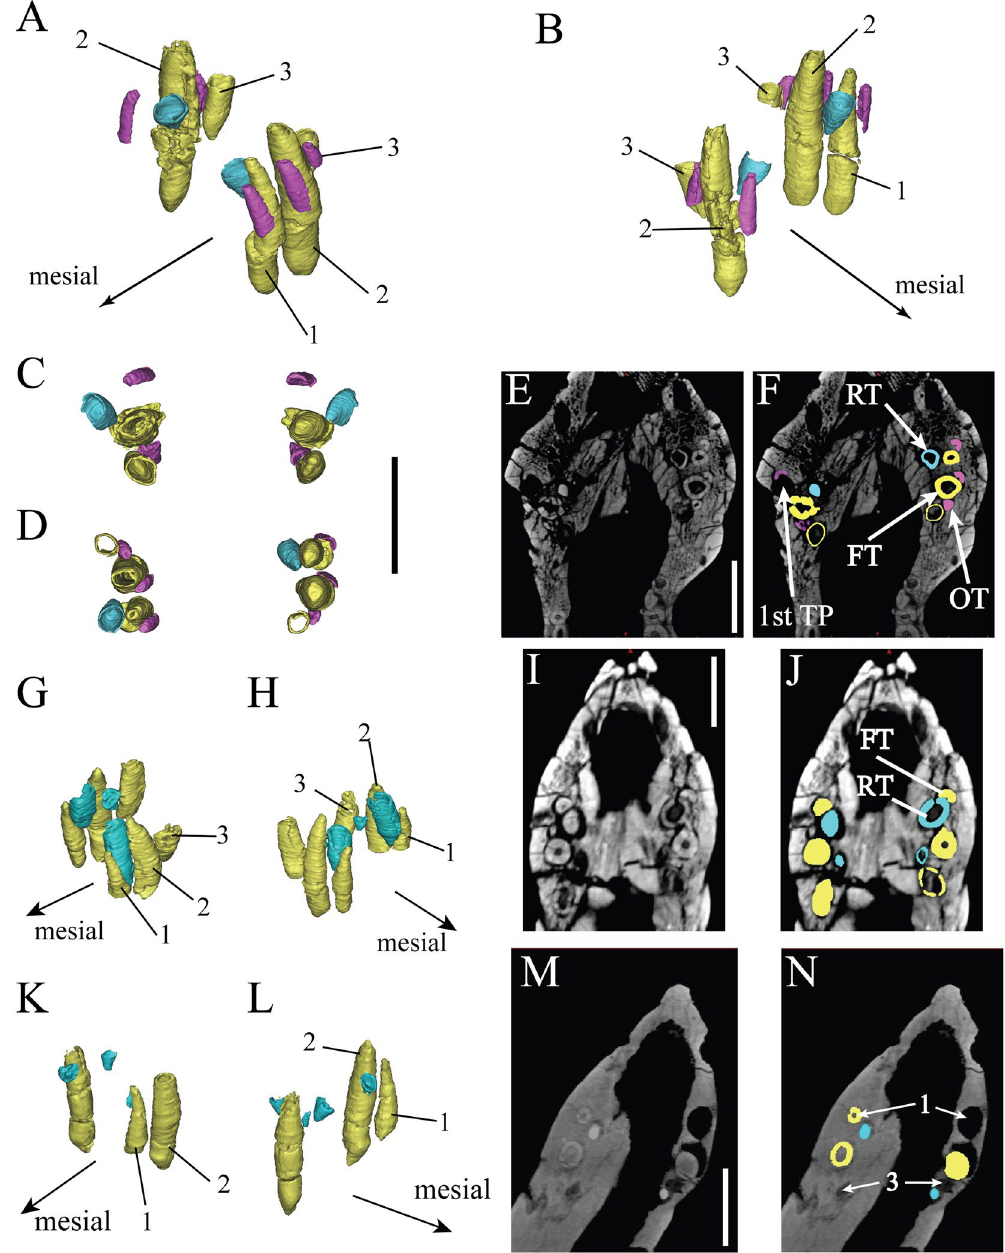
Figure 1. Liaoceratops yanzigouensis premaxillary teeth of IVPP V12738 ( A – F ), IVPP V12633 ( G – J ) and CAGS-IG-VD-002 ( M – R ). Elements in the CT reconstructions are color-coded as follows: right and left functional premaxillary teeth, yellow; right and left replacement premaxillary teeth, cyan; right and left remnants of mostly resorbed functional premaxillary teeth, magenta. Reconstructed and extracted premaxillary teeth composite in left ( A ) and right ( B ) mesial-labial view; ( C ) reconstructed and extracted left premaxillary teeth composite in dorsal (left) and ventral (right) view; ( D ) reconstructed and extracted right premaxillary teeth composite in dorsal (left) and ventral (right) view. ( E and F ) longitudinal CT cross sections through the premaxilla of IVPP V12738. Numbers indicate tooth positions from mesial to distal. Scale bars equal 10 mm ( C – F ). Reconstructed and extracted premaxillary teeth composite of IVPP V12633 in left ( G ), right ( H ) mesial- labial view; ( I , J) longitudinal CT cross sections through the premaxilla of IVPP V12633. ( K – N ) reconstructed and extracted premaxillary teeth composite of CAGS-IG-VD-002 in left ( K ) and right ( L ) mesial-labial view; Longitudinal CT cross sections through the premaxilla of CAGS-IG-VD-002 ( M , N) . Numbers indicate tooth positions from mesial to distal. Scale bars equal 5 mm ( I , J , M , N